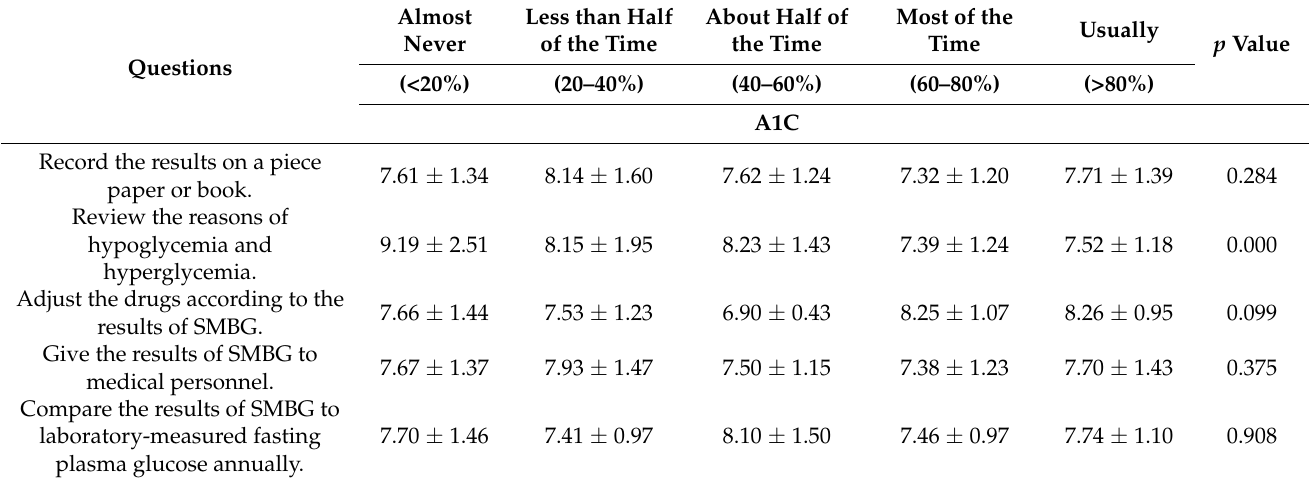
Table 4. Behavior of SMBG restricted to patients who checked SMBG in the past 1 month ( n =